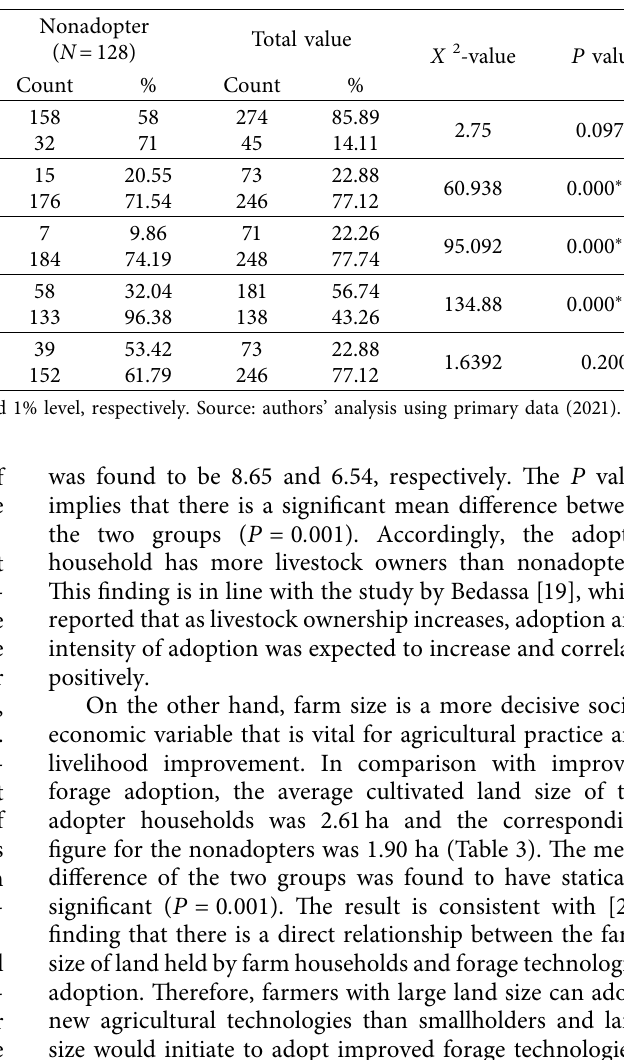
Table 4: Demographic and socioeconomic characteristics for binary variables ( X 2